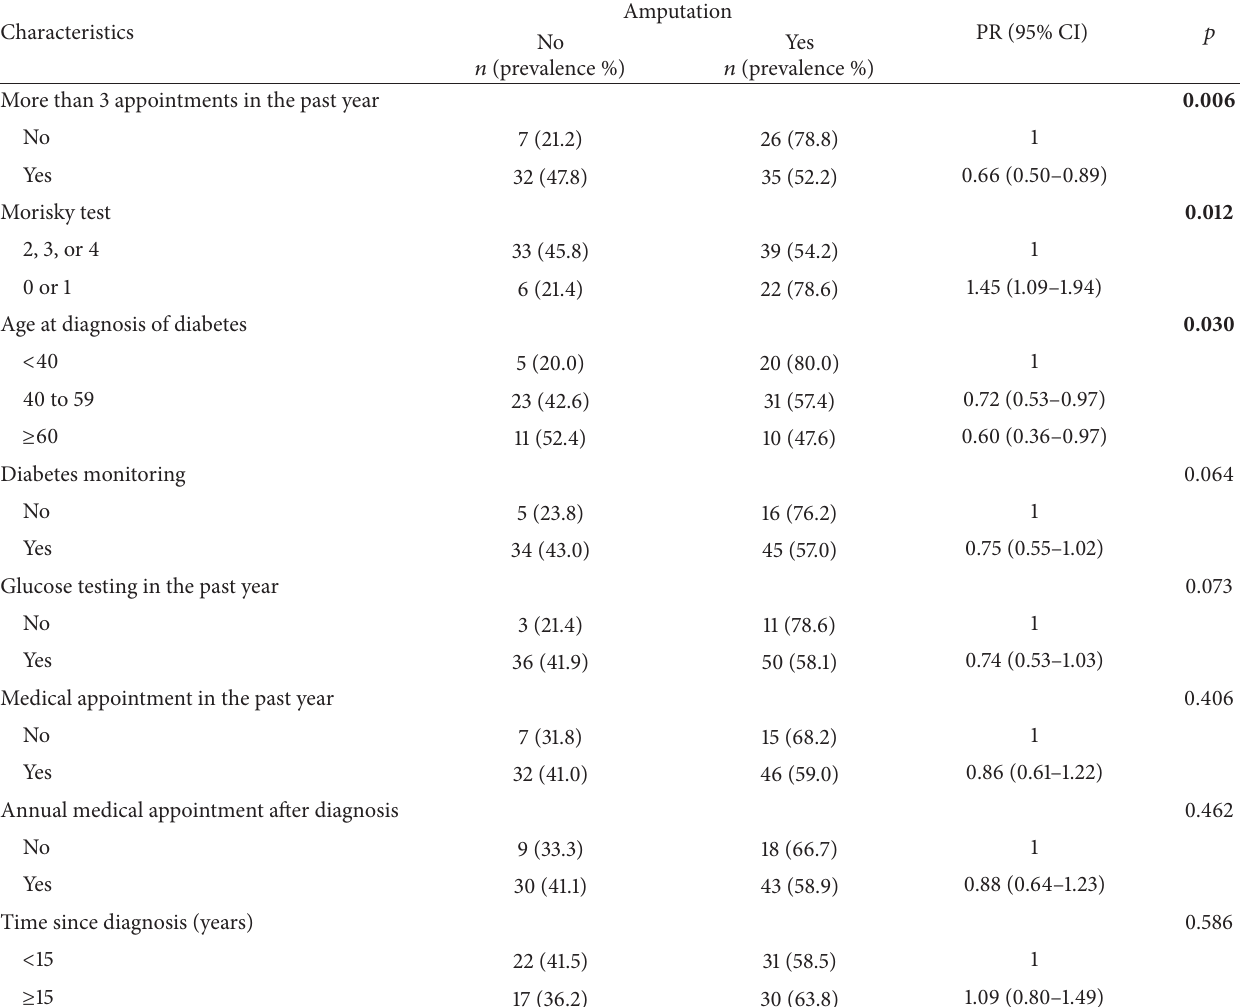
Table 3: Distribution of patients with diabetes by age, time to diagnosis, and diabetic care in relation to foot amputation.